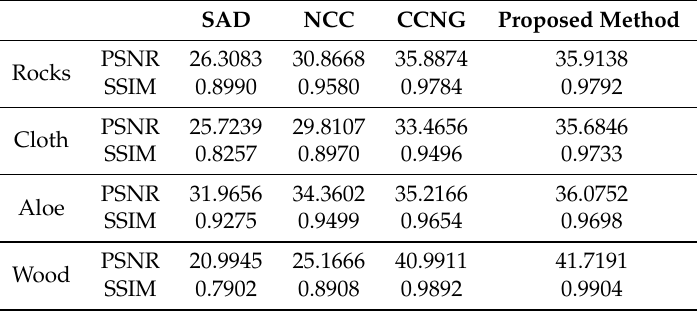
Table 3. Quantitative registration comparison using PSNR and SSIM between our method and conventional